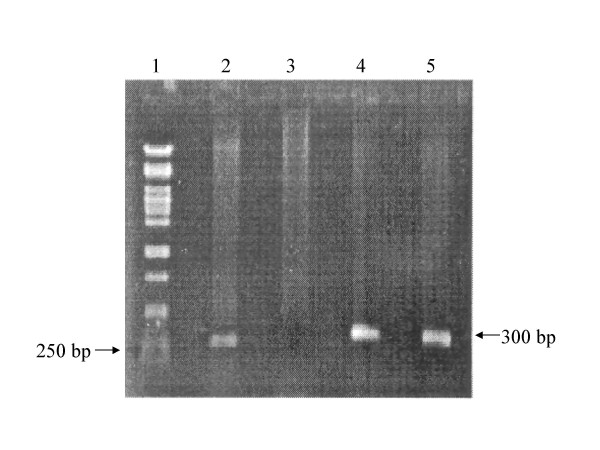
RT-PCR of SMMUpos and SMMUneg fibronectin expression. RT-PCR of SMMUpos and SMMUneg fibronectin expression using fibronectin primers. Lane 1: PST I DNA marker: Lane 2: Fibronectin expression in SMMUpos; Lane 3: Fibronectin expression in SMMUneg; Lane 4: β-actin expression in SMMUpos; Lane 5: β-actin expression in SMMUneg.